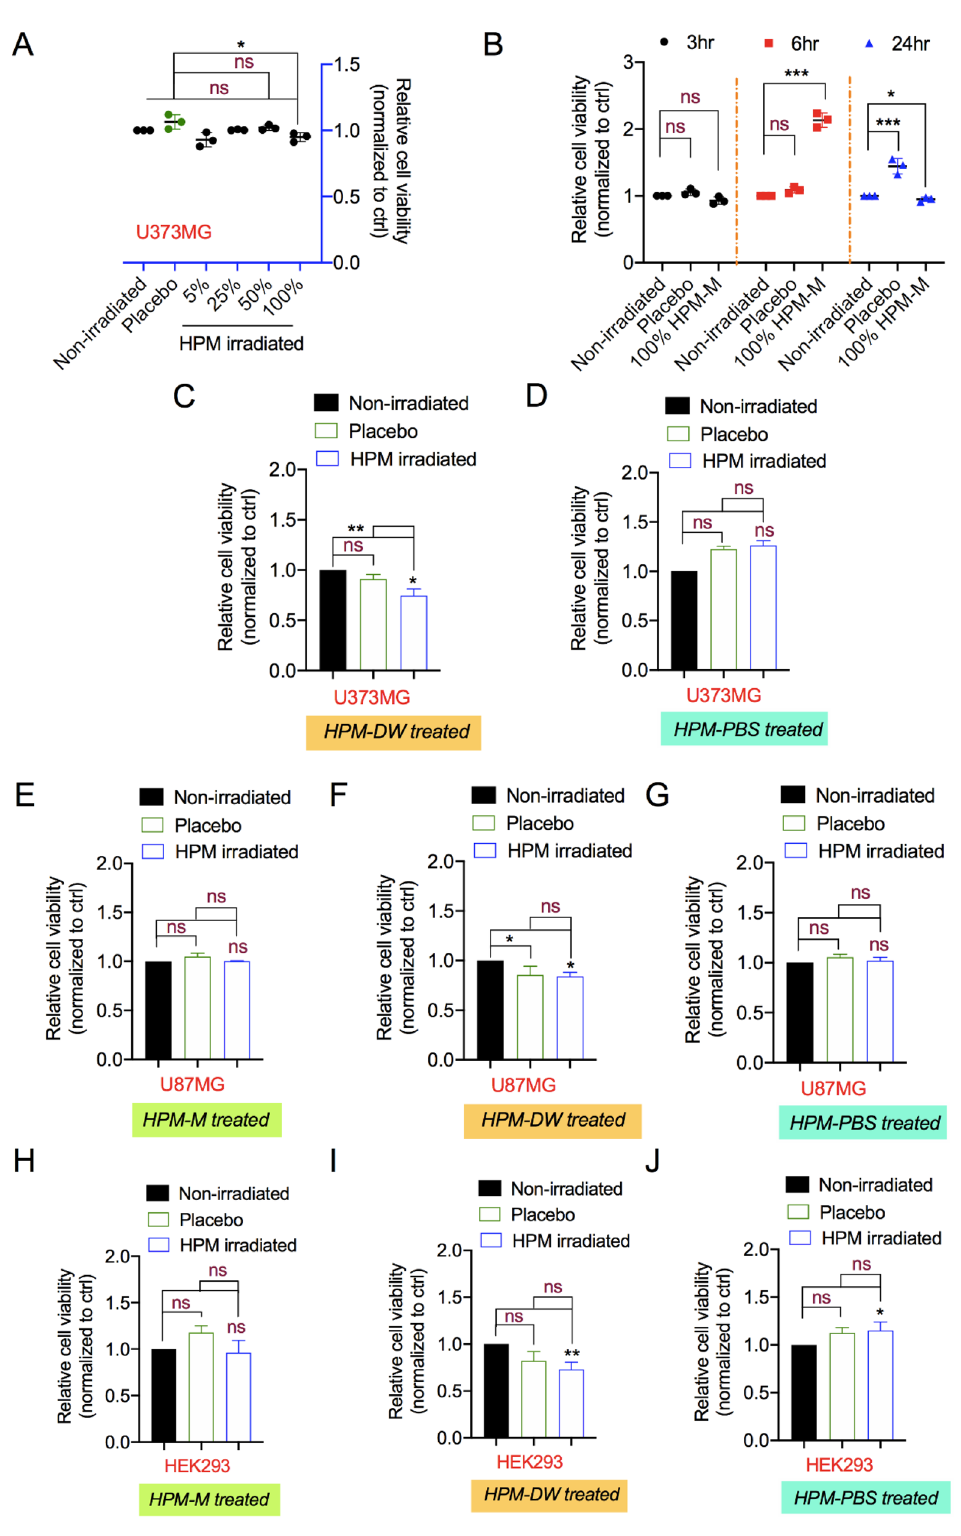
Figure 3. Assessment of high power microwave-irradiated solutions for cytotoxicity. ( A ) Relative viability of cells treated with increasing concentrations (5%, 25%,50%, and 100%) of high power microwave (HPM)- irradiated complete DMEM. ( B ) Relative viability of cells incubated for different times (3, 6, and 24 h) after treatment with HPM-irradiated complete DMEM (100%). Relative cellular viability measured using the Alamar Blue assay in U373MG cells treated with HPM-irradiated ( C ) Media, ( D ) DW, and ( E ) PBS. Similarly, relative viability was measured in U87MG cells treated with HPM-irradiated ( F ) Media, ( G ) DW, and ( H ) PBS, as well as in HEK293 cells treated with HPM-irradiated ( I ) Media, ( J ) DW, and ( K ) PBS. Non-significance is denoted as ns. * p < 0.05, ** p < 0.01, *** p <